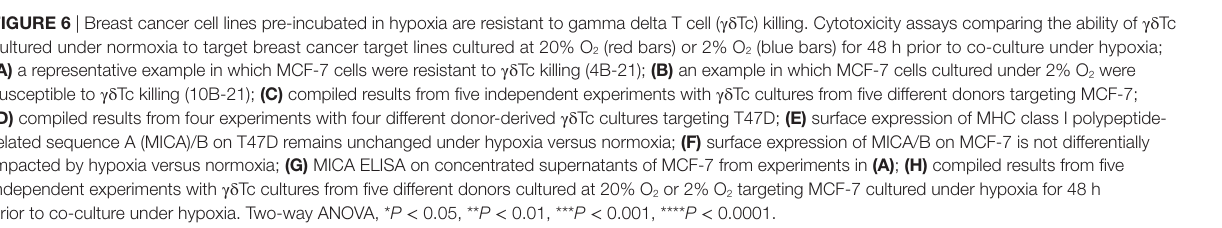
FigUre 6 | Breast cancer cell lines pre-incubated in hypoxia are resistant to gamma delta T cell ( γδ Tc) killing. Cytotoxicity assays comparing the ability of γδ Tc cultured under normoxia to target breast cancer target lines cultured at 20% O 2 (red bars) or 2% O 2 (blue bars) for 48 h prior to co-culture under hypoxia; (a) a representative example in which MCF-7 cells were resistant to γδ Tc killing (4B-21); (B) an example in which MCF-7 cells cultured under 2% O 2 were susceptible to γδ Tc killing (10B-21); (c) compiled results from five independent experiments with γδ Tc cultures from five different donors targeting MCF-7; (D) compiled results from four experiments with four different donor-derived γδ Tc cultures targeting T47D; (e) surface expression of MHC class I polypeptide- related sequence A (MICA)/B on T47D remains unchanged under hypoxia versus normoxia; (F) surface expression of MICA/B on MCF-7 is not differentially impacted by hypoxia versus normoxia; (g) MICA ELISA on concentrated supernatants of MCF-7 from experiments in (a) ; (h) compiled results from five independent experiments with γδ Tc cultures from five different donors cultured at 20% O 2 or 2% O 2 targeting MCF-7 cultured under hypoxia for 48 h prior to co-culture under hypoxia. Two-way ANOVA, * P < 0.05, ** P < 0.01, *** P < 0.001, **** P <